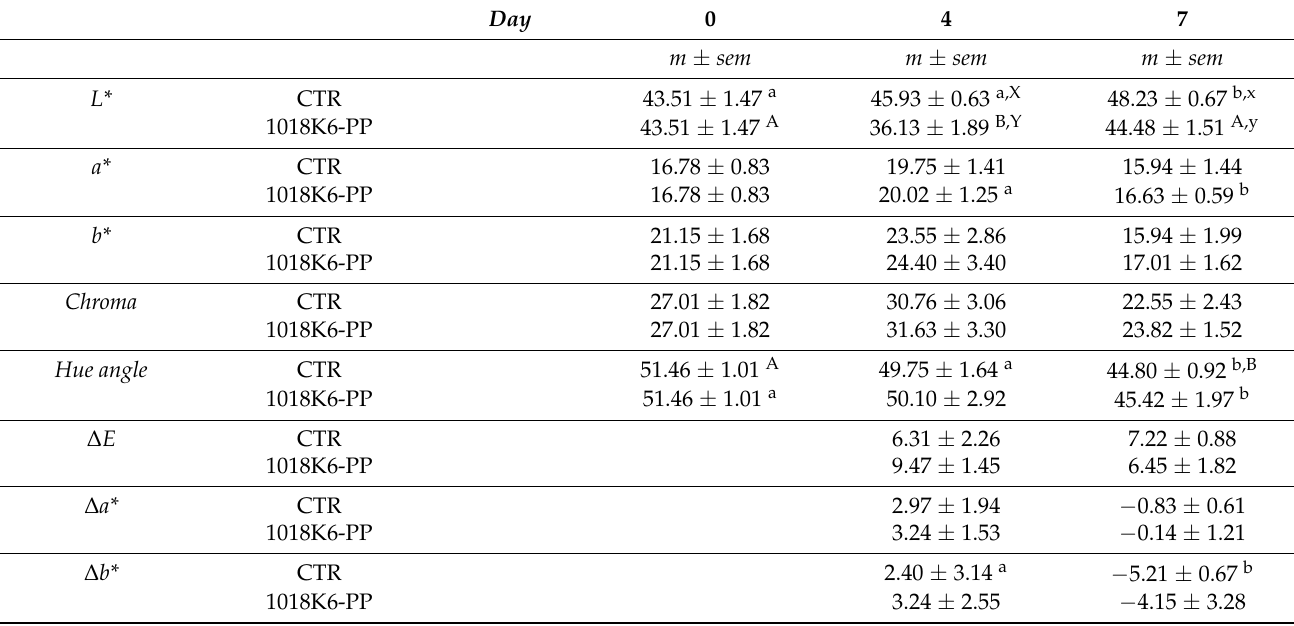
Table 2. Changes in colour indices of the salmon fillets packaged in active PP films functionalized with 1018K6 by storage